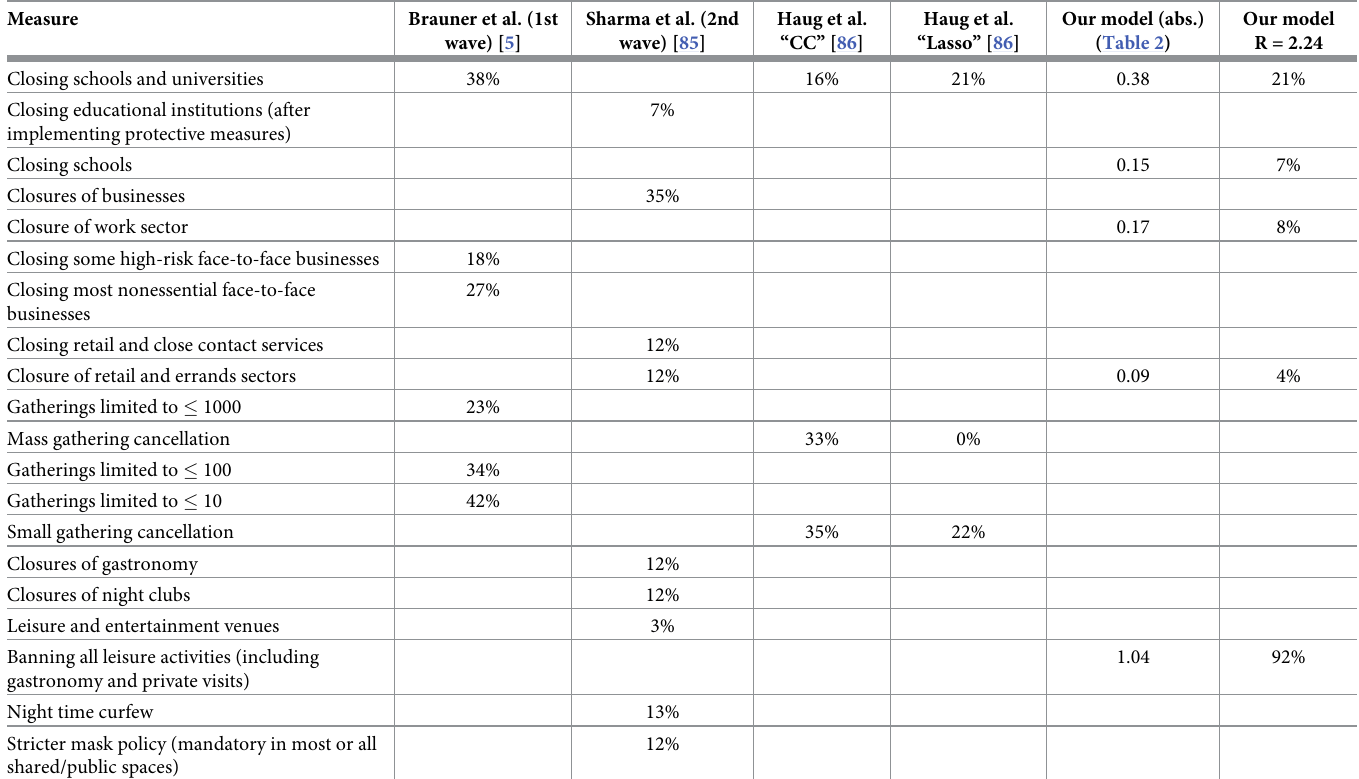
Table 5. Percent reduction of R in other